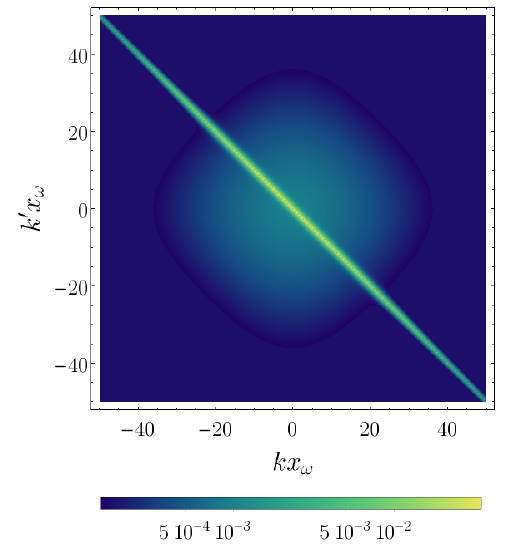
( k , k ′ ) , in units of x 2 , for finding a fermion ω ab